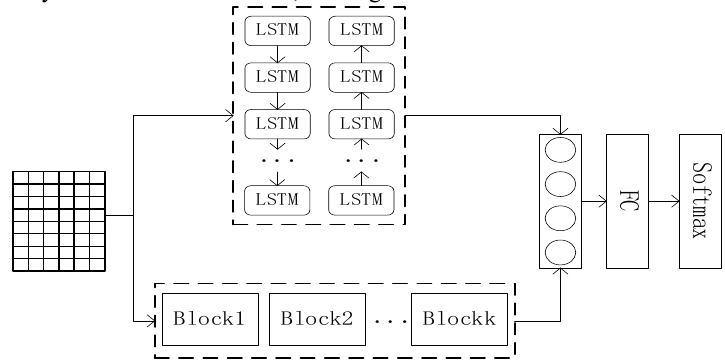
Fig. 3. Overall structure diagram of the